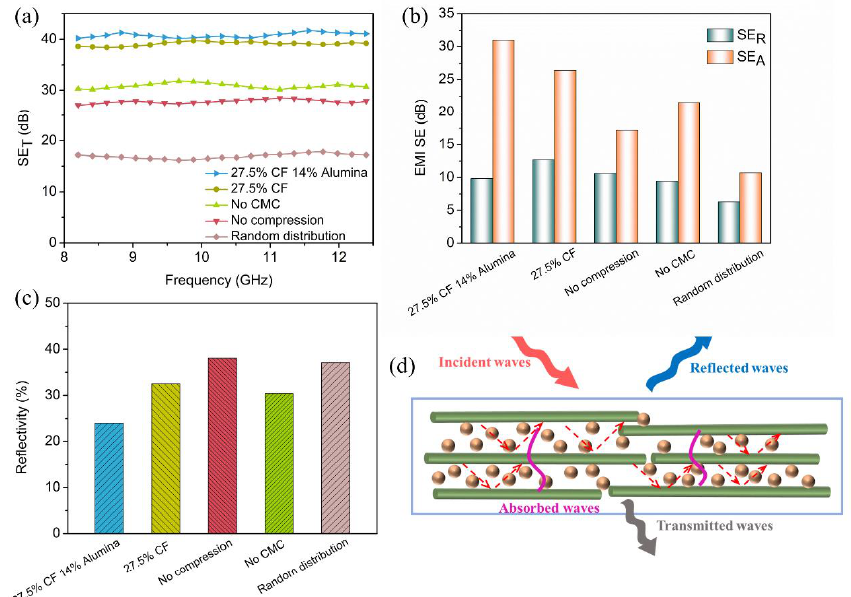
Figure 9. EMI shielding performance of the PDMS/alumina/CF composite, the PDMS/CF composite, the composite without compression, the composite without CMC and the composite with the randomly distributed filler: ( a ) SE T over the X-band frequency ranges, ( b ) SE A and SE R , ( c ) reflectivity and ( d ) EMI shielding mechanism of the PDMS/alumina/CF composite.